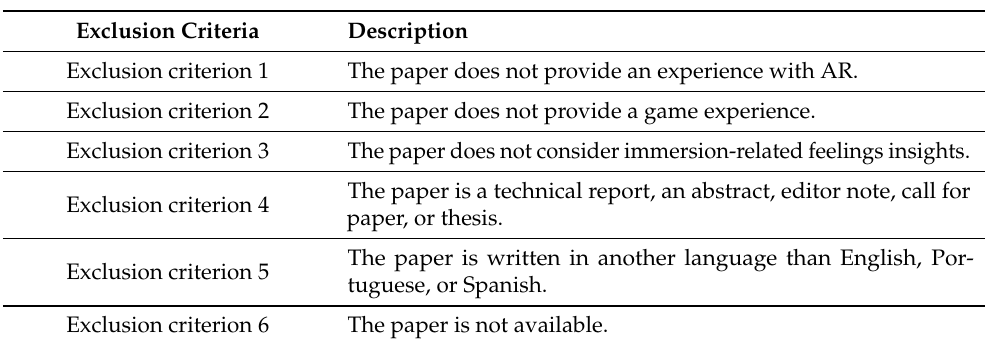
Table 2. Exclusion